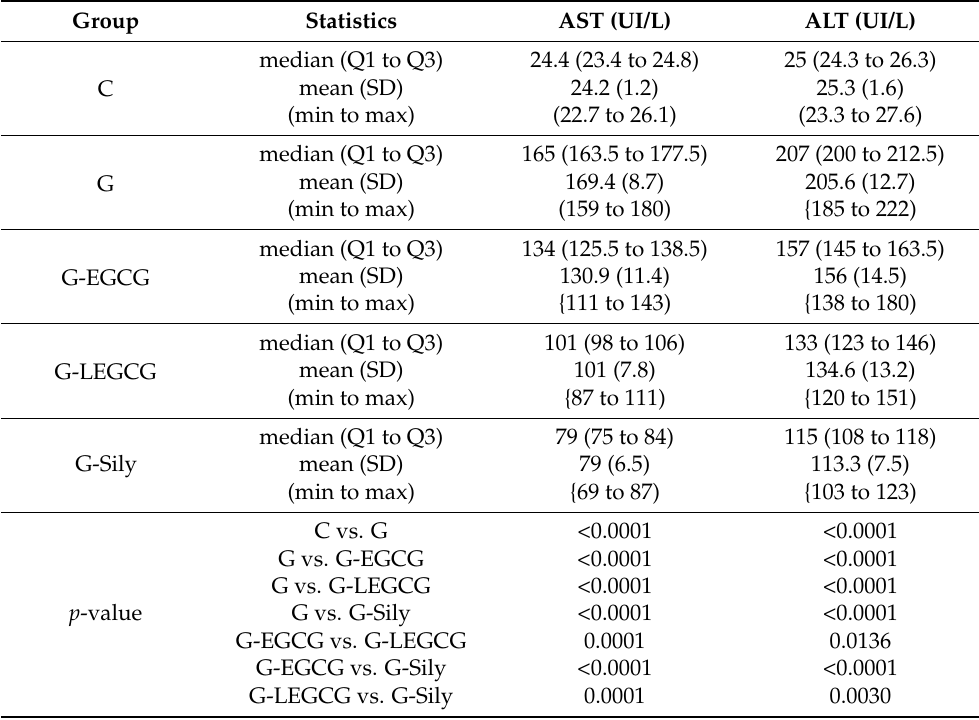
Table 1. Hepatic function (serum markers—AST and ALT) after gentamicin administration. The comparative effect of EGCG, LEGCG, and